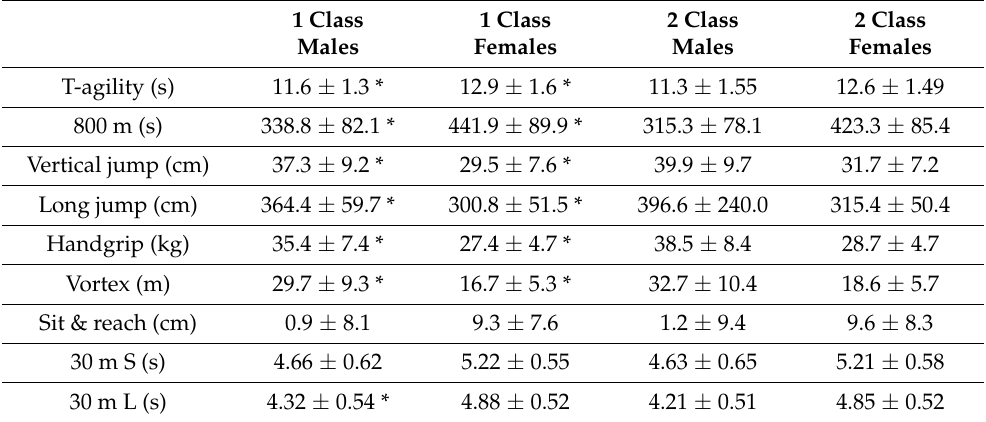
Table 1. Average values and st. dev. fitness tests divided according to sex and class categories. The differences between sexes in both the first and second class are always significant in any test with p < 0.001. * Significant differences between the first and second classes of the same